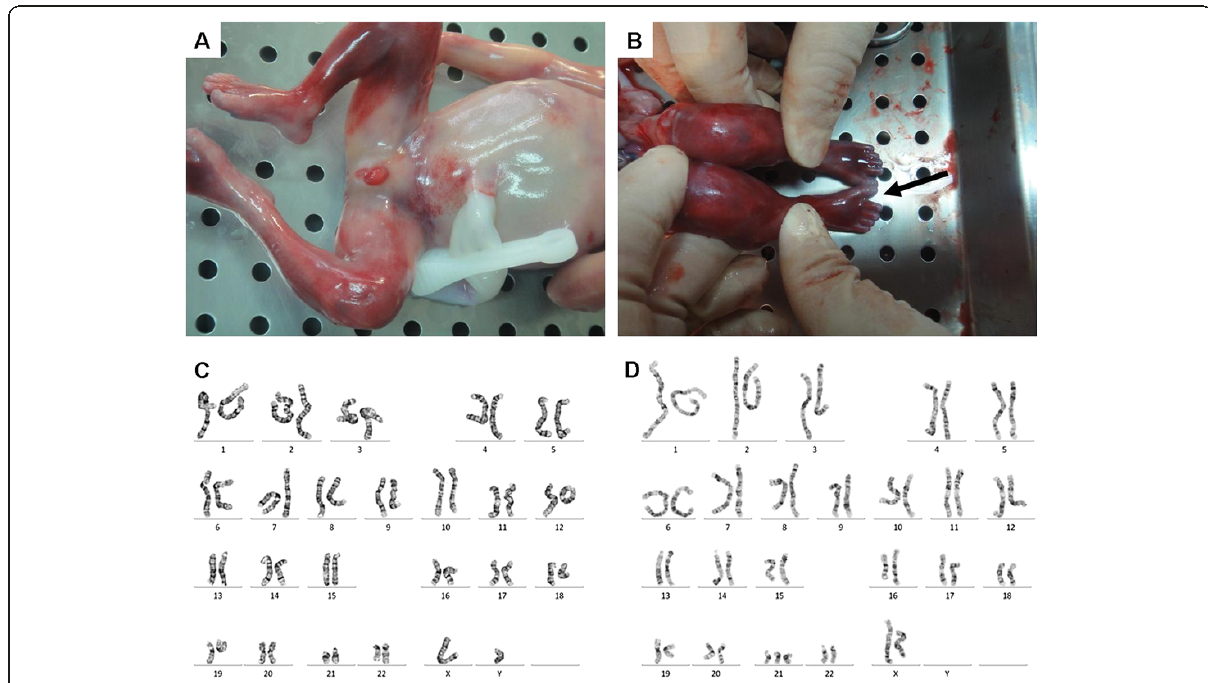
Figure 1 Autopsy and karyotypes of the chimera fetus. The aborted fetus exhibits normal external genitalia ( A ) and no characteristics typical of Down syndrome except the enlarged gap between the first and the second toes ( B ) was observed. The fetal karyotypic ratio of 46,XY ( C ) to 47, XX,+21 ( D ) in cortical cells was